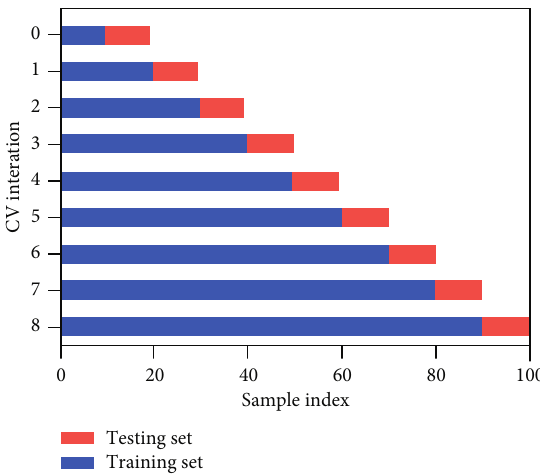
Figure 2: Cross-validation time series split.